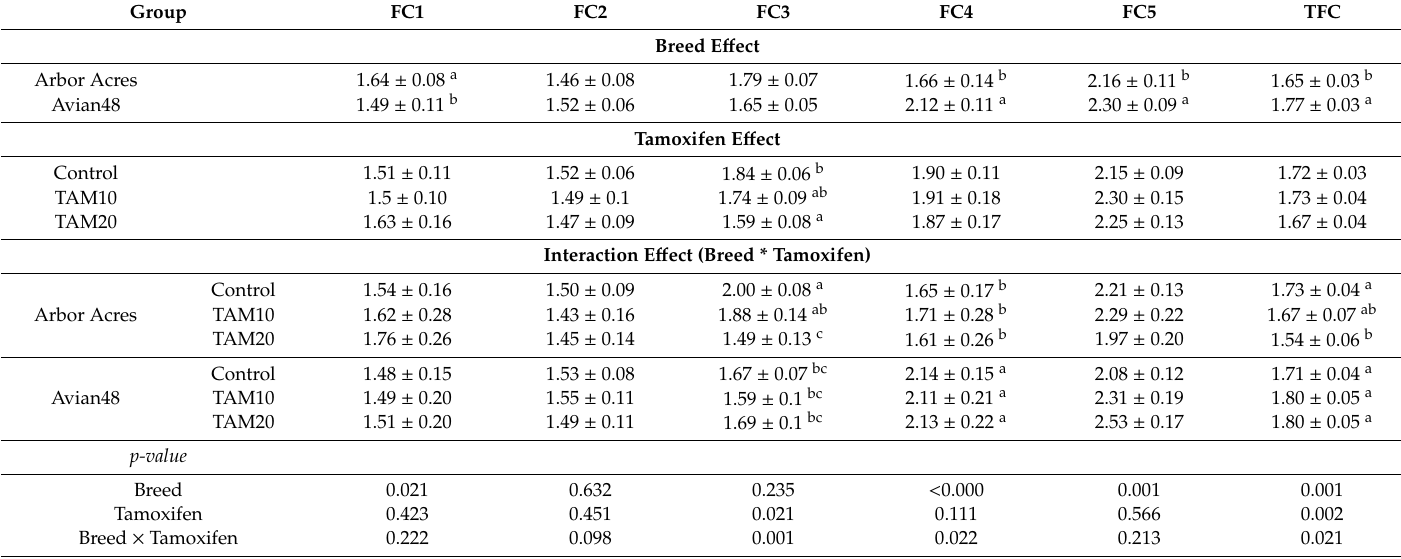
Table 5. The e ff ect of breed, Tamoxifen treatments and their interactions on weekly feed conversion (Means ±